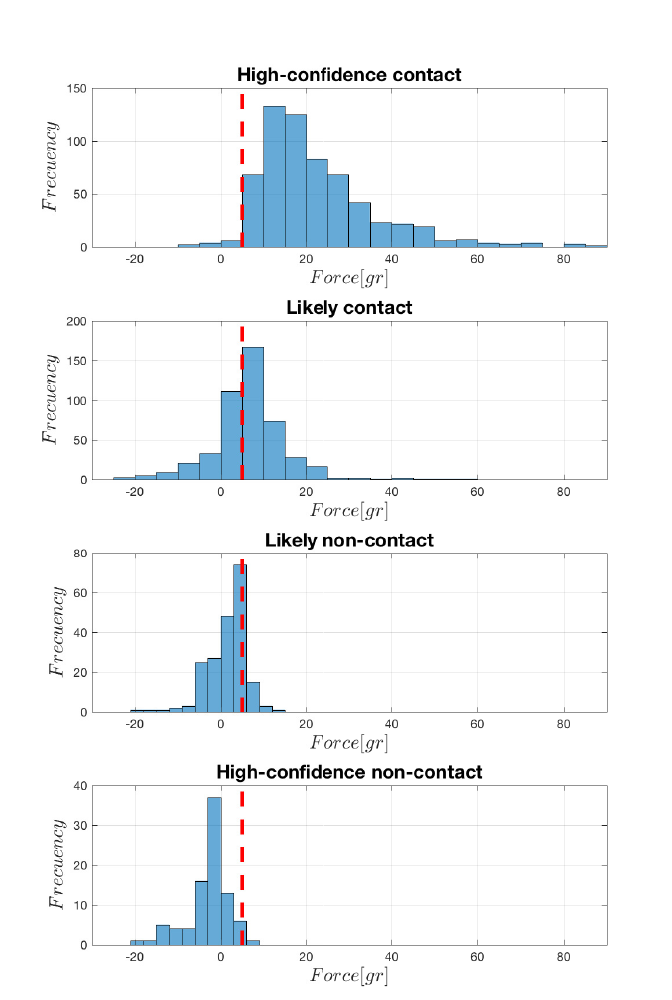
Figure 2. Histograms of the force signal values at the time of the EGM peak, according to the conventional criterion. The 5-gr threshold is depicted (vertical red